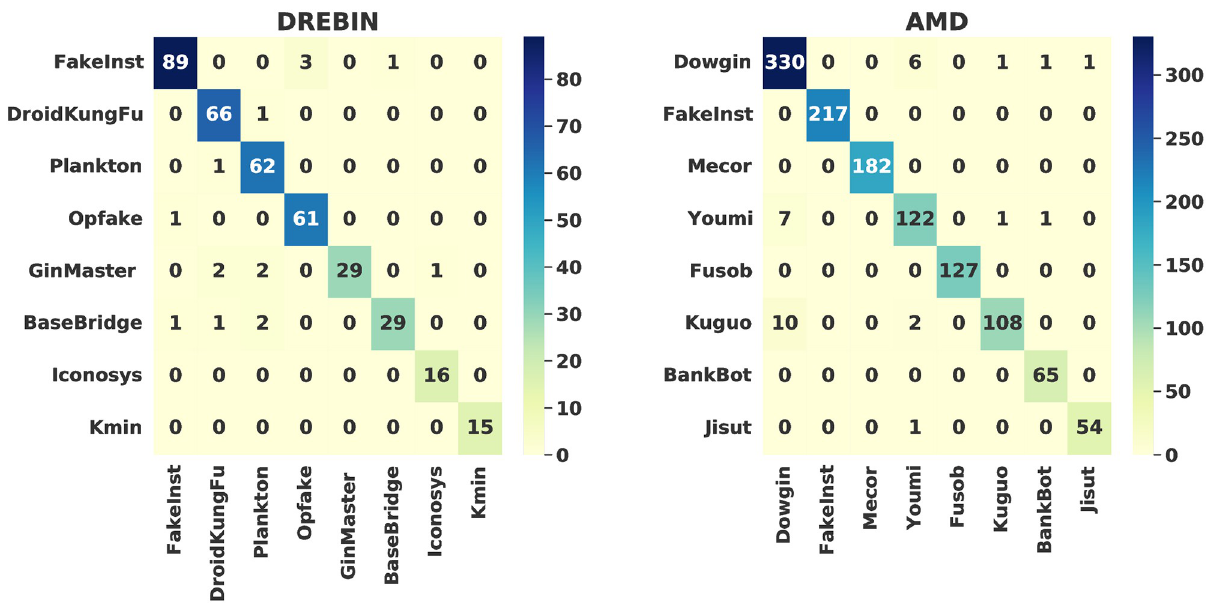
Fig 4. Confusion matrix of the proposed CNN algorithm (DAM format).